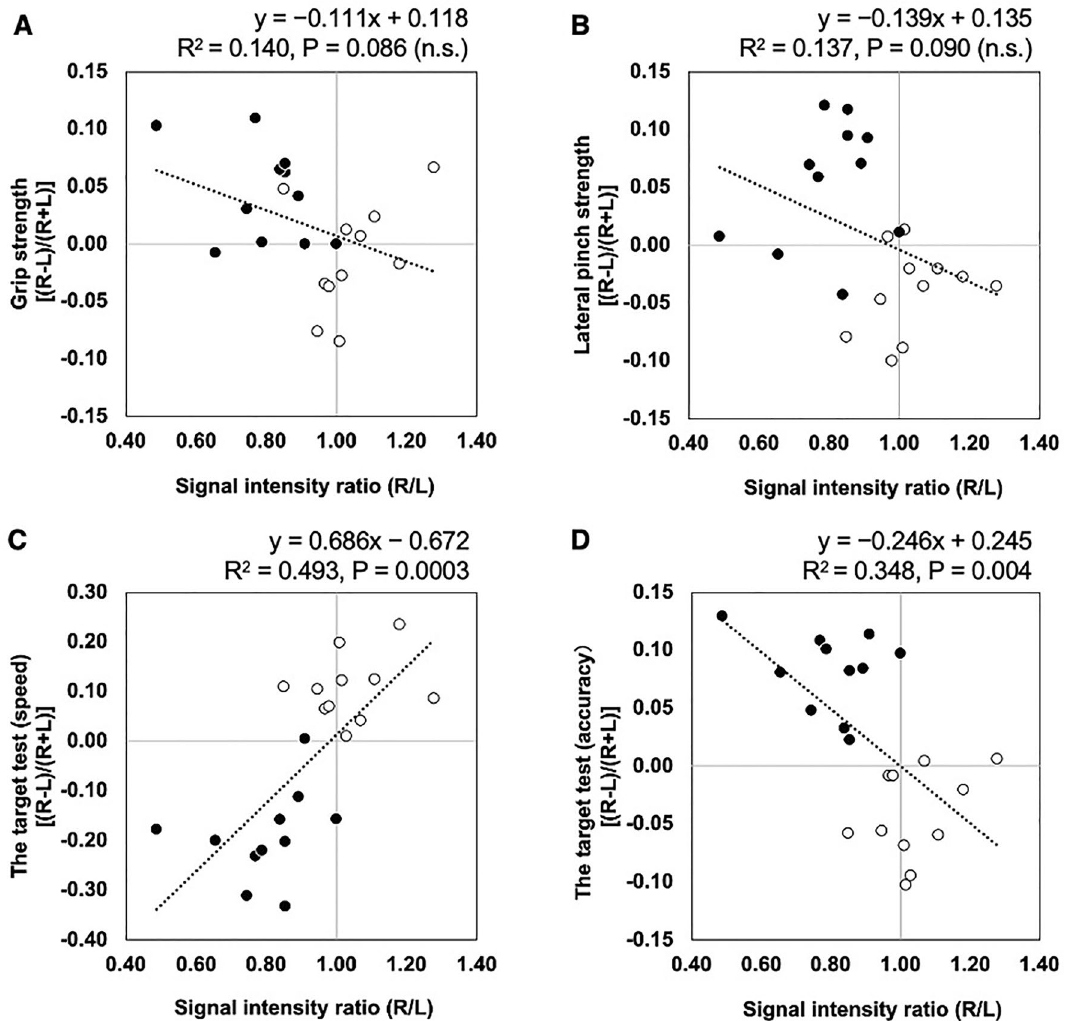
Figure 4. Relations among signal intensity ratios of CFT structures and hand motor performance asymmetry indices. ( A ) Grasp strength. ( B ) Lateral pinch strength. ( C ) Target test (speed test). ( D ) Target test (accuracy test). Black circles indicate right-handed participants. White circles indicate left-handed participants. n.s. non-